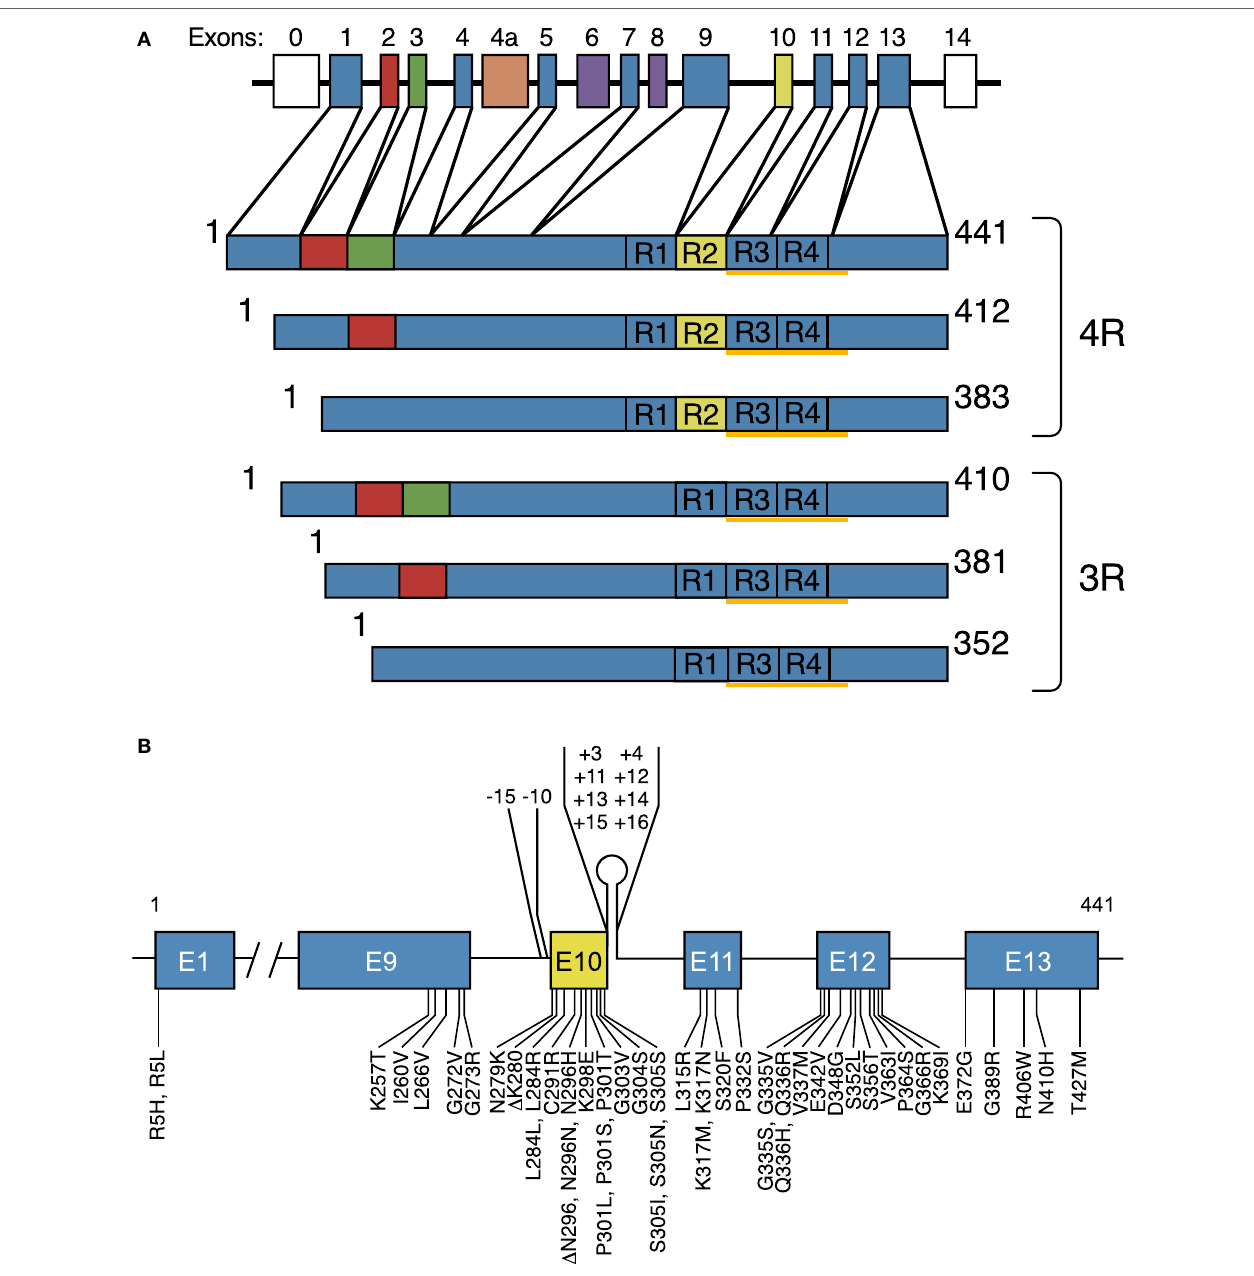
FigURe 1 | Human brain Tau isoforms and disease-causing MAPT mutations. (A) MAPT and the six Tau isoforms expressed in adult human brain. MAPT consists of 16 exons (E). Alternative mRNA splicing of E2 (red), E3 (green), and E10 (yellow) gives rise to six Tau isoforms (352–441 amino acids). The constitutively spliced exons (E1, E4, E5, E7, E9, E11, E12, and E13) are shown in blue. E0, which is part of the promoter, and E14 are non-coding (white). E6 and E8 (violet) are not transcribed in human brain. E4a (orange) is only expressed in the peripheral nervous system. The repeats (R1–R4) are shown, with three isoforms having four repeats each (4R) and three isoforms having three repeats each (3R). The core sequences of the Tau filaments from Alzheimer’s disease brain (V306-F378) determined by cryo-EM are underlined. (B) , Mutations in MAPT in cases of frontotemporal dementia and parkinsonism linked to chromosome 17 (FTDP-17T). Forty-nine coding region mutations and 10 intronic mutations flanking E10 are